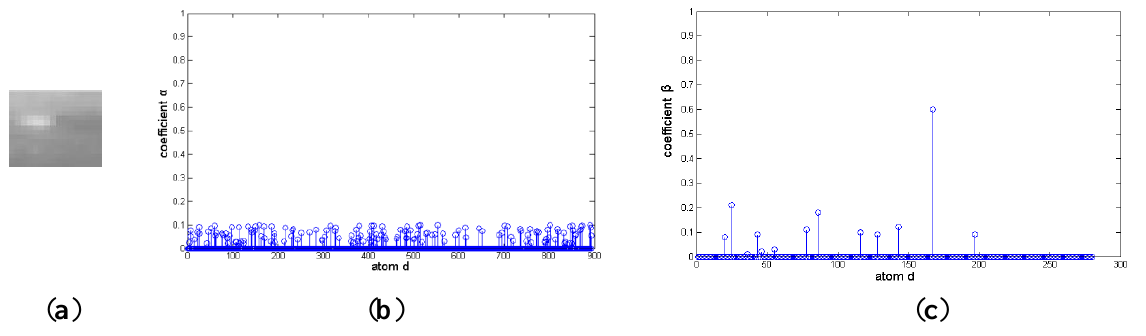
Figure 12. Representation coefficient of target signal in cloud image decomposed on discriminative over-complete dictionary. ( a ) Target signal. ( b ) Sparse coefficient on background dictionary. ( c ) Sparse coefficient on target